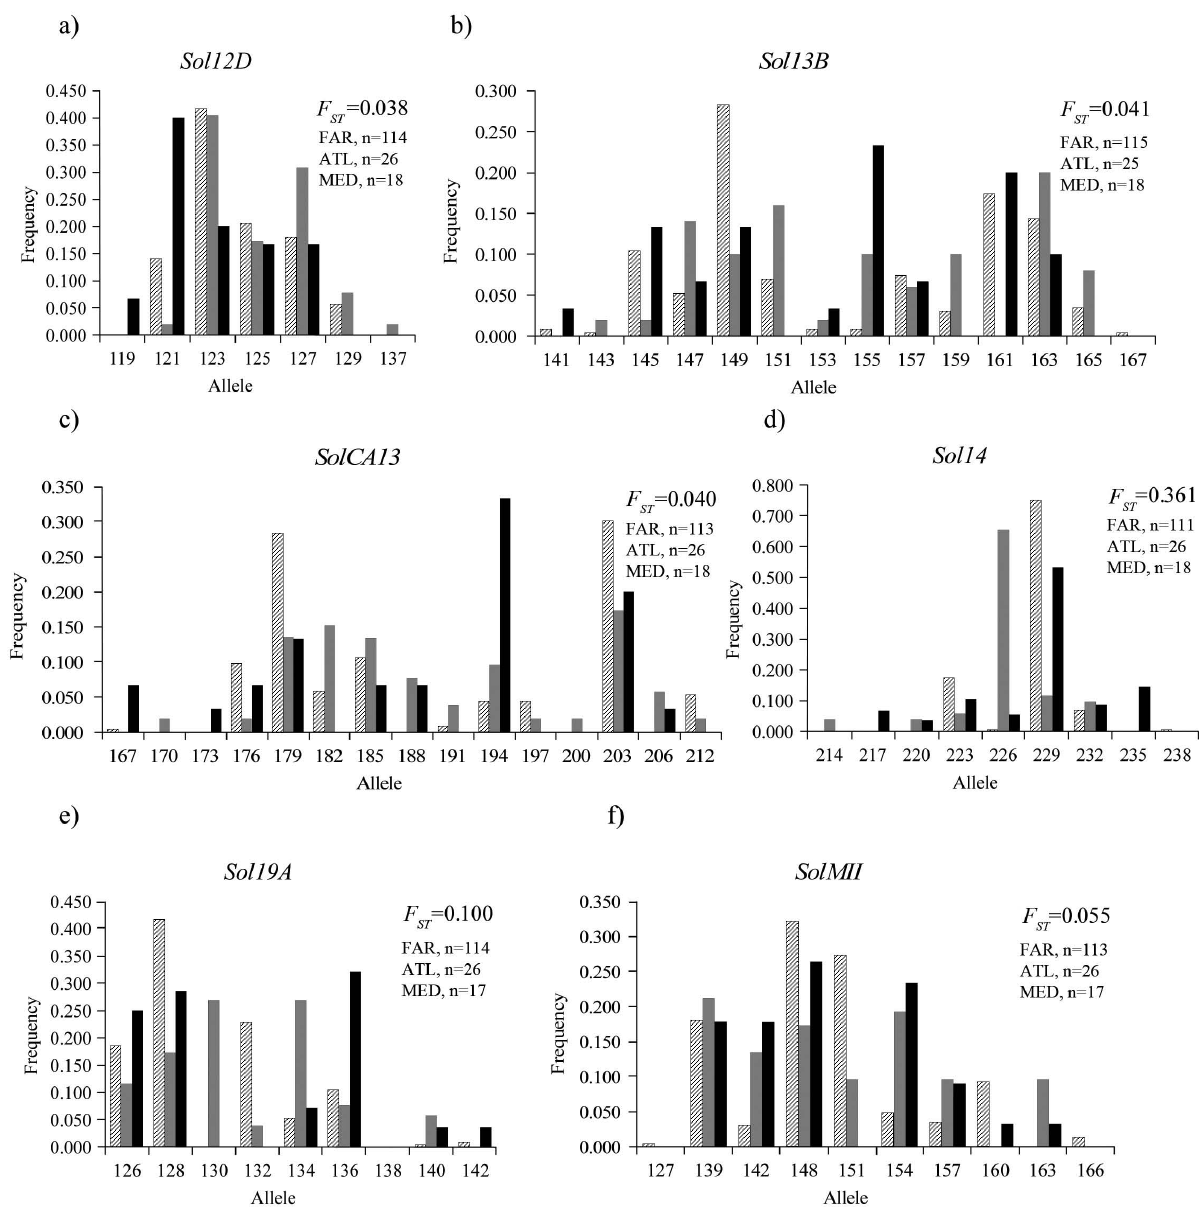
Fig . 2. – Allele frequencies for each of the six microsatellite loci characterized in this study. a) Sol12D , b) Sol13B , c) SolCA13 , d) Sol14 , e) Sol19A and f) SolMII for the three Senegalese sole samples: FAR (pattern bars); ATL (grey bars); MED (black bars). The number (n) of individuals per sample characterized for each locus is given. On each x-axis, the allele sizes (bp) for each locus, and on each y-axis the cor- responding relative frequency. F for each locus estimated among the three ST